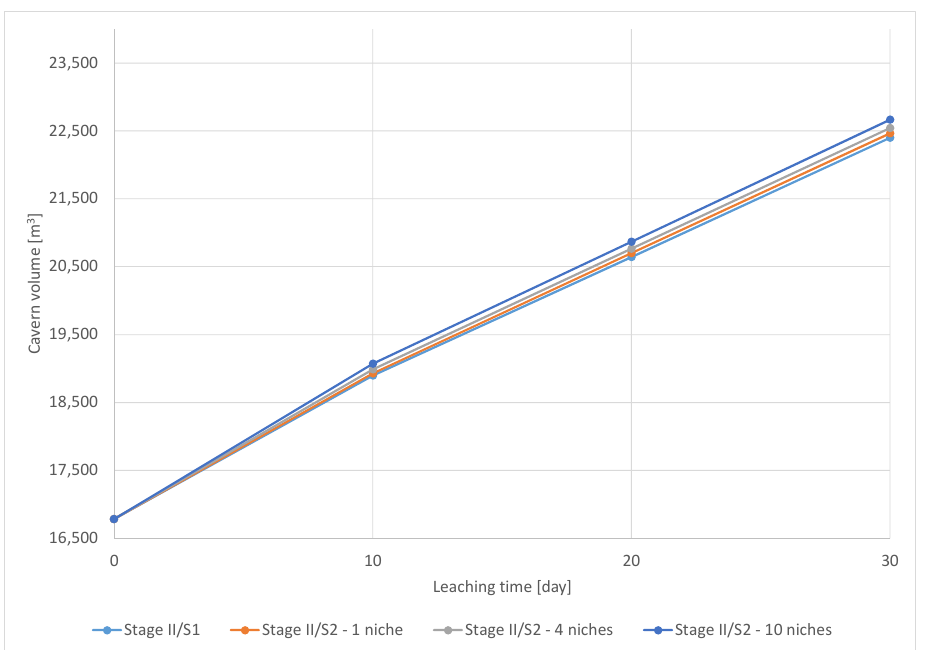
Figure 16. Comparison of the change in cavern volume for Phase I of Stage II—the first 30 days for different scenarios.